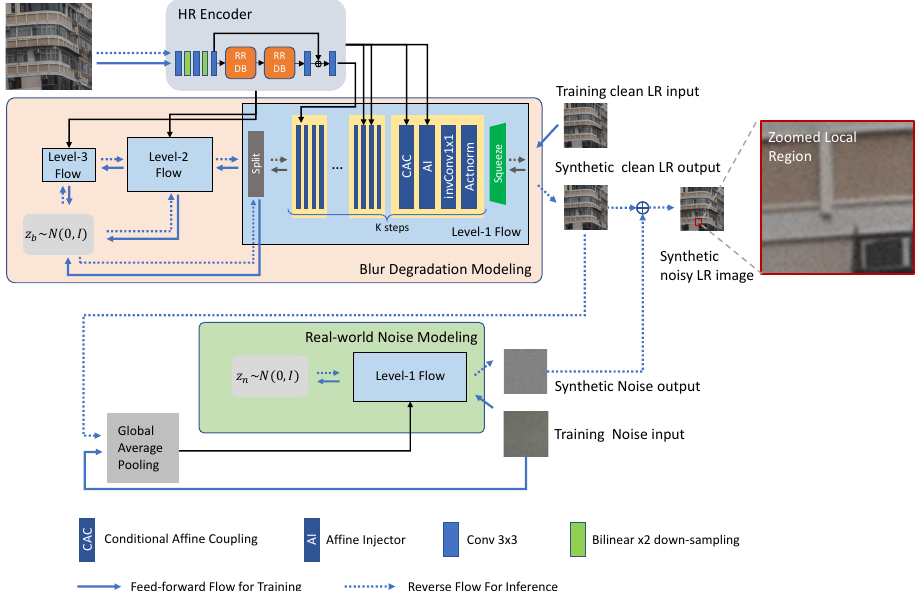
Figure 1. Overall architecture of IDFlow for image degradation modeling. The blue solid lines correspond to the training procedure, and the blue dotted lines correspond to the inference